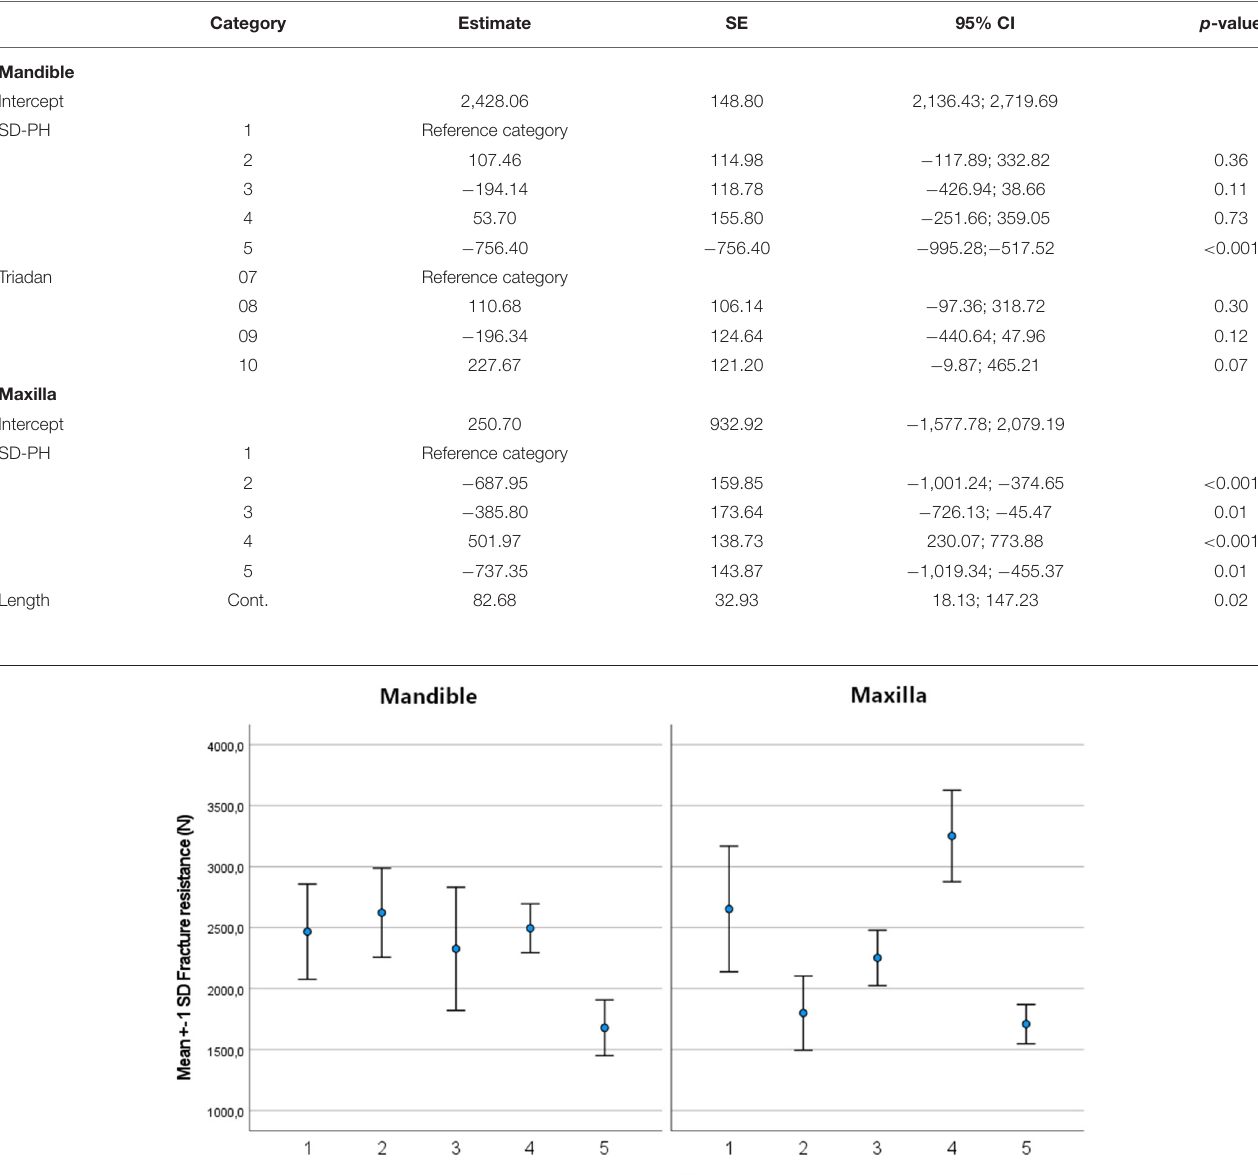
TABLE 2 | Results of the final multivariable model of factors significantly influencing the fracture resistance of cheek teeth in the first study population. Category